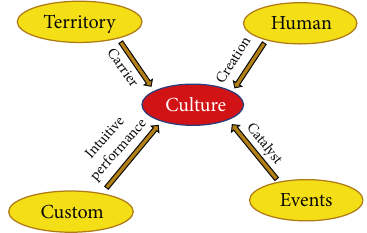
Figure 2: Ontology model conceptual